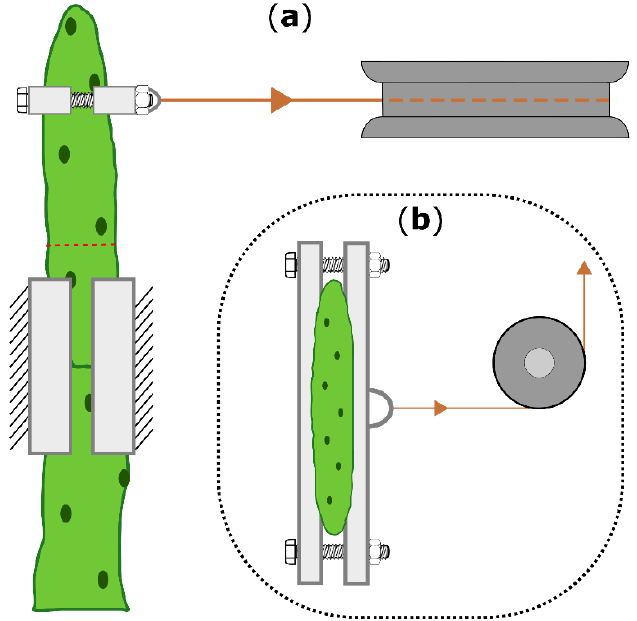
Figure 6. Schematic drawing of the two-point bending arrangement, shown for Opuntia ficus-indica . ( a ): Top view of the bending zone, including the 3D-printed clamps and collars (bright boxes), the pulley (dark gray), the Kevlar thread (orange), and the location of the ring incision (dashed red line). ( b ): Front view with attached collars and the pulley deflecting a vertical into a horizontal force. The universal testing machine above the pulley, which allows vertical force measurement, is not shown.